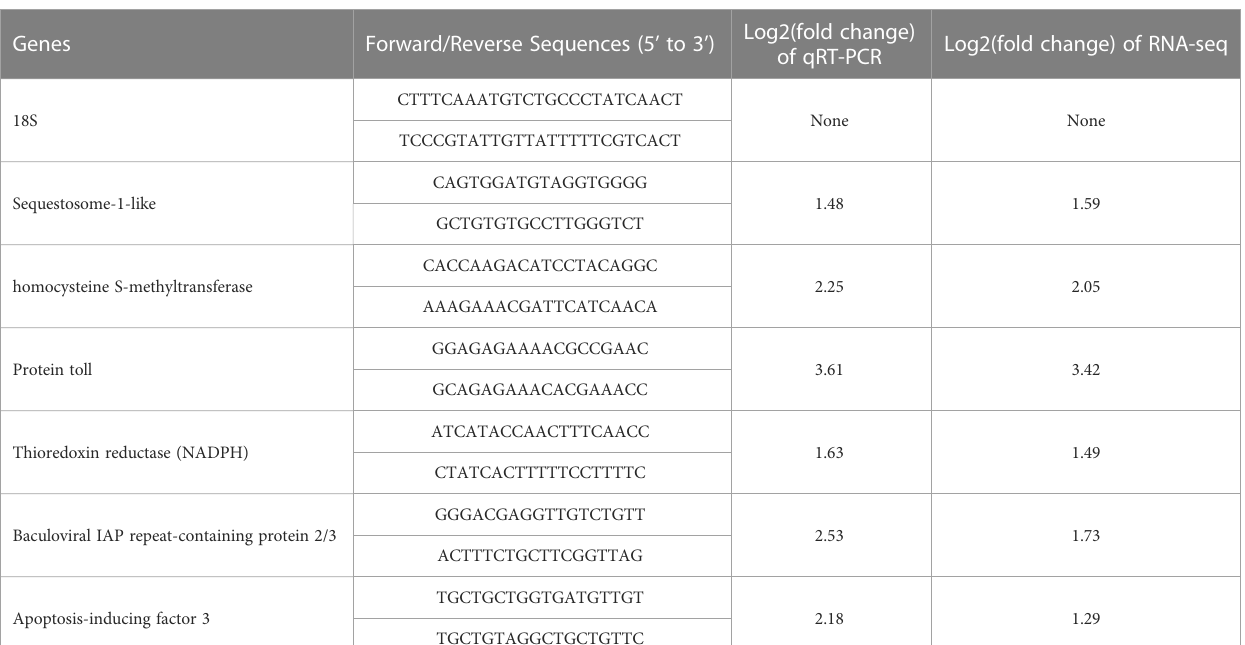
TABLE 1 Primer sequences and internal reference used for qRT-PCR